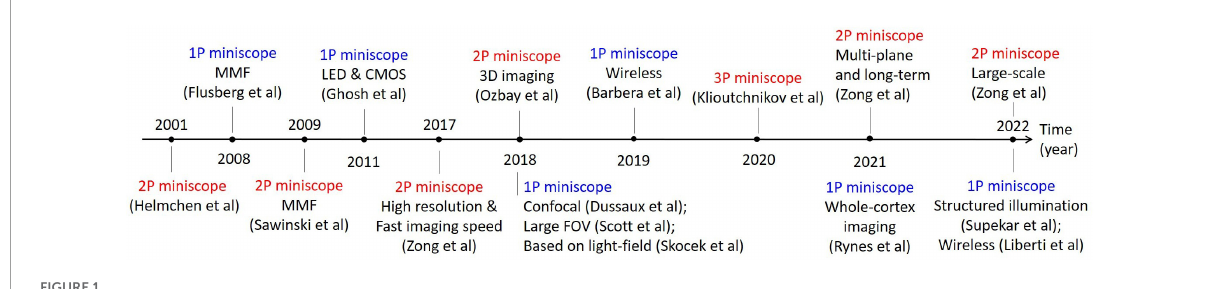
FIGURE1 Typical works in the development of optical miniscopes for in vivo imaging in freely moving animals.